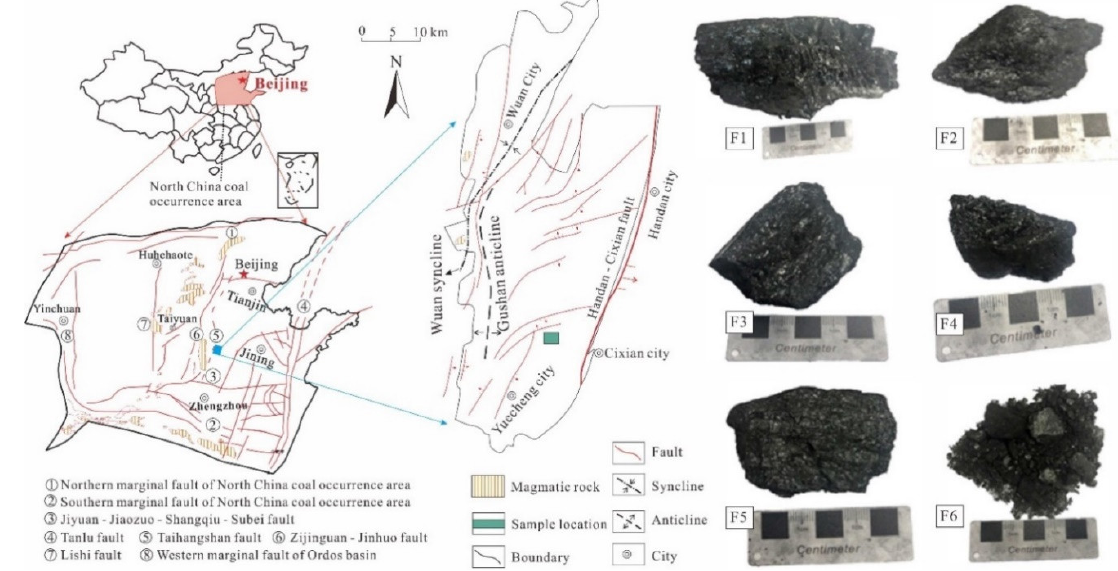
Figure1. Figure 1. Geological structure of Fengfeng coal mine area with tectonically deformed coal (TDC) samples.